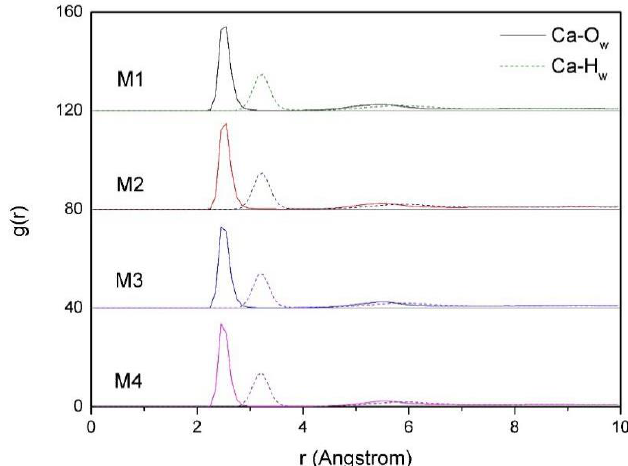
Figure 6. The radial distribution function (RDF) of Ca-O w and Ca-H w of montmorillonites with different layer charge density.